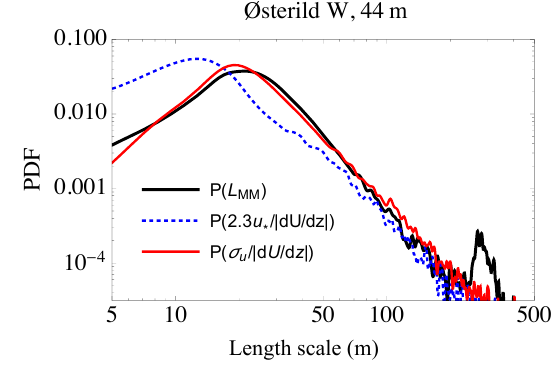
Figure 6. Probability density function of turbulent length scale from observations at Østerild from the western mast/lidar. Black: Mann-model scale from fits to spectra; dotted-blue: “mixing- length” formulation ( (cid:96) m ∝ u ∗ / | d U/ d z | ) with revised constant; red: new form (15), σ u / | d U/ d z |